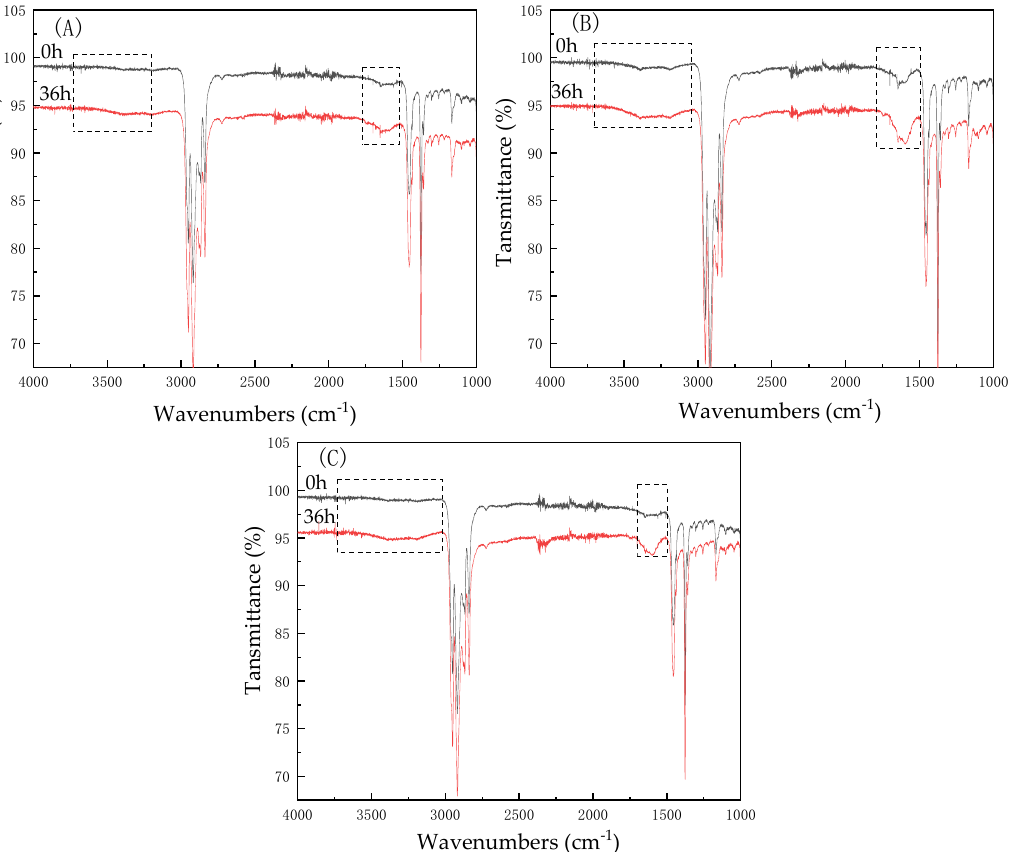
Figure 4. Changes in FT − IR spectra of the outer ( A ), middle ( B ), and inner ( C ) layers after 0 h and 36 h of UV irradiation. ( A ) Comparison between 0 h and 36 h of irradiation time of the outer layer on FT − IR spectra changes; ( B ) comparison between 0 h and 36 h of irradiation time of the middle layer on FT − IR spectra changes; and ( C ) comparison between 0 h and 36 h of irradiation time of the inner layer on FT − IR spectra changes. (For each condition, N = 6).